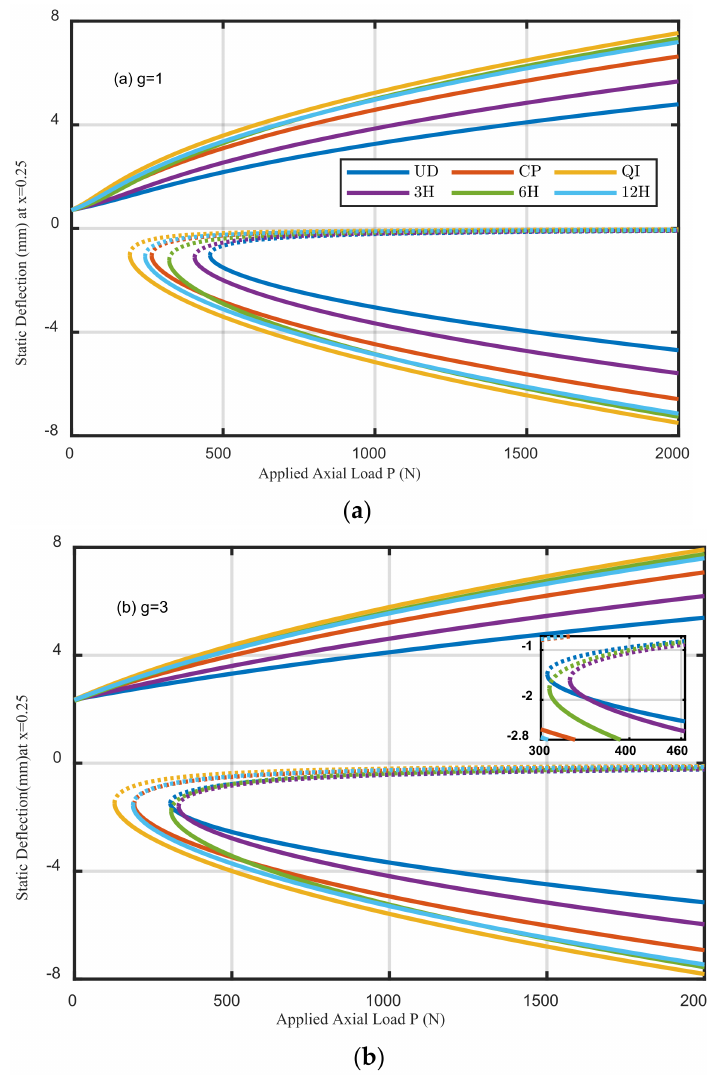
Figure 7. Load-deflection response related to first buckling mode of the S–S imperfect composite beam with different layup configurations. ( k L = 20, k s = 0, L = 100 h ). For the imperfection ( a ) g = 1 and ( b ) g =